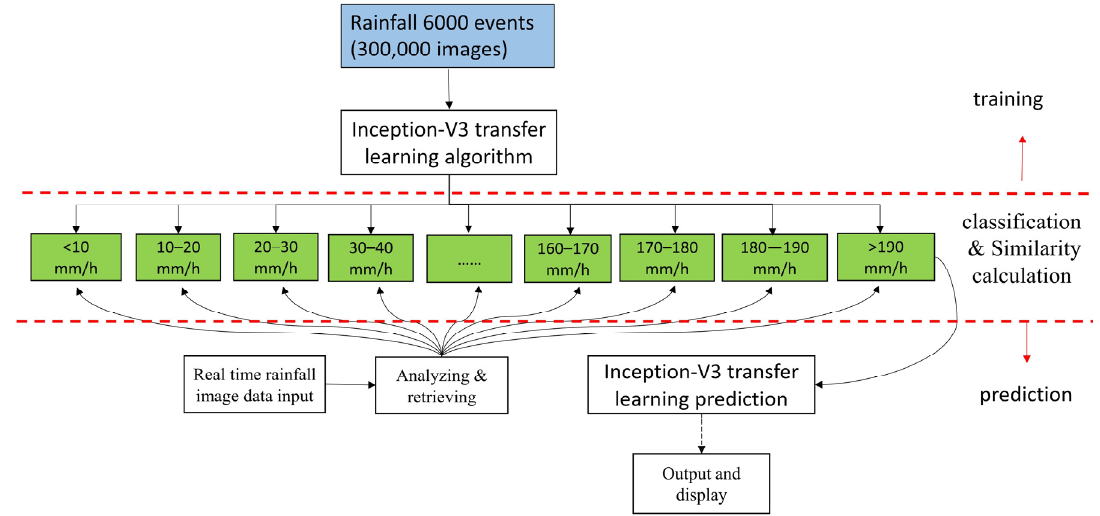
Figure 5. The architecture of the artificial intelligence platform of the study.